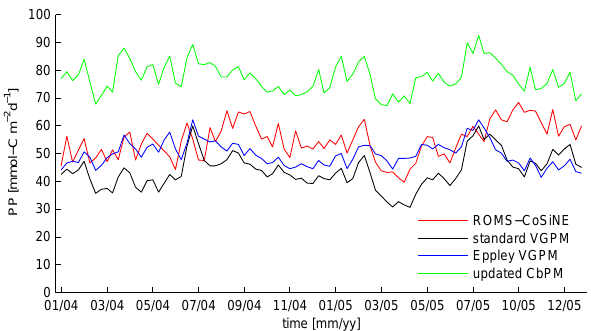
Fig. 5. 2004–2005 time series comparison of ROMS–CoSiNE model primary productivity (red line) with satellite-derived esti- mates of productivity from the standard VGPM (black line) re- sult, Eppley-modified VGPM result (blue line) and the updated CbPM result (green line). All data are averaged over the EEP re- gion. Satellite data come from http://www.science.oregonstate.edu/ ocean.productivity/. See text for a detailed description of satellite model PP algorithms.